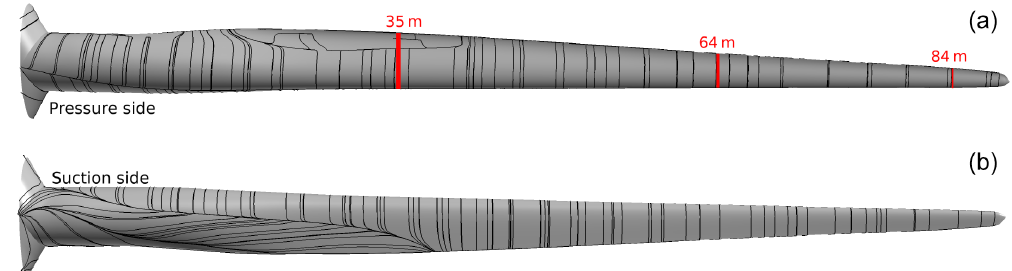
Figure A3. Surface-restricted streamlines from the EllipSys solution for a wind speed of 8ms − 1 , both for the pressure side (a) and the suction side (b) for the perturbed design we use as a starting point for the optimization. The operational conditions are listed in Table A1.